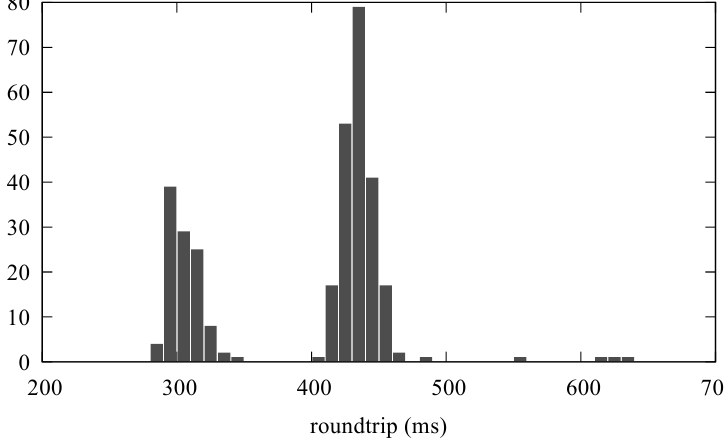
Figure 7. Round-trip time with the reference time server, as measured during clock synchronization.